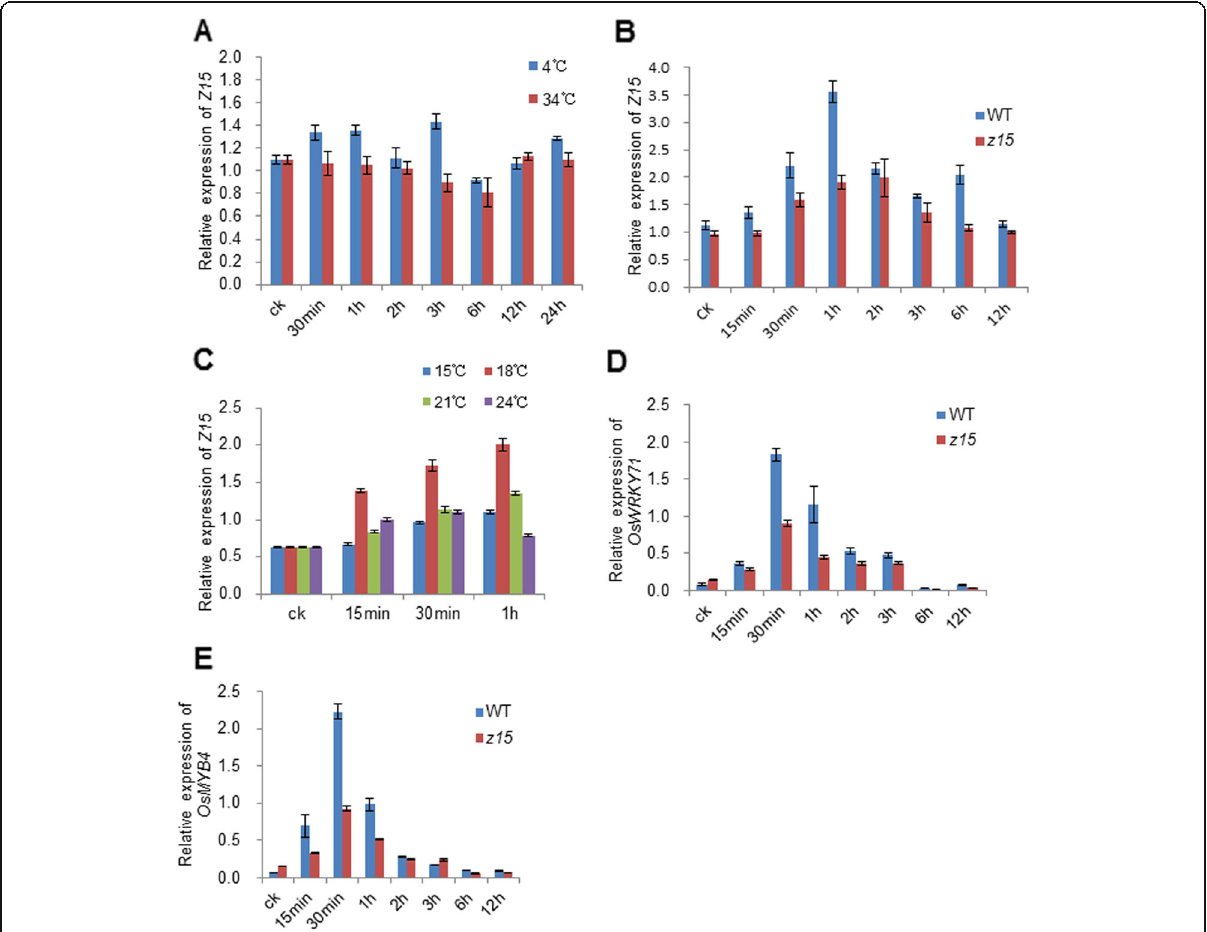
Fig. 6 Influence of temperature on expression of Z15. a Expression of Z15 at 4 °C and 34 °C, respectively. b Expression of Z15 in wild type and z15 mutant at 18 °C. c Expression of Z15 at 15, 18, 21, and 24 °C, respectively. d The expression of OsWRKY71 at 18 °C. e The expression of OsMYB4 at 18 °C . Error bars represent the standard deviation (SD) of three biological